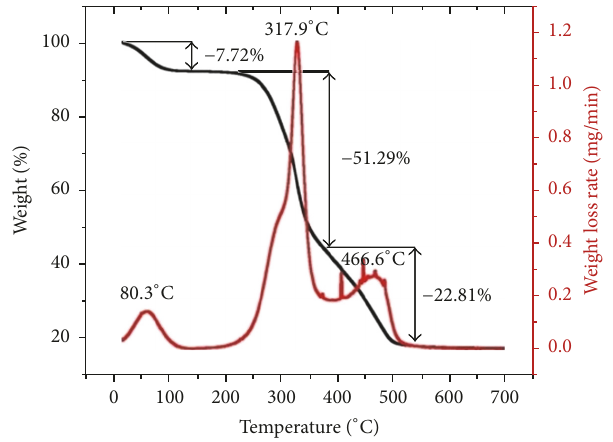
Figure 1: Raw rice husk’s thermogravimetric analyses.